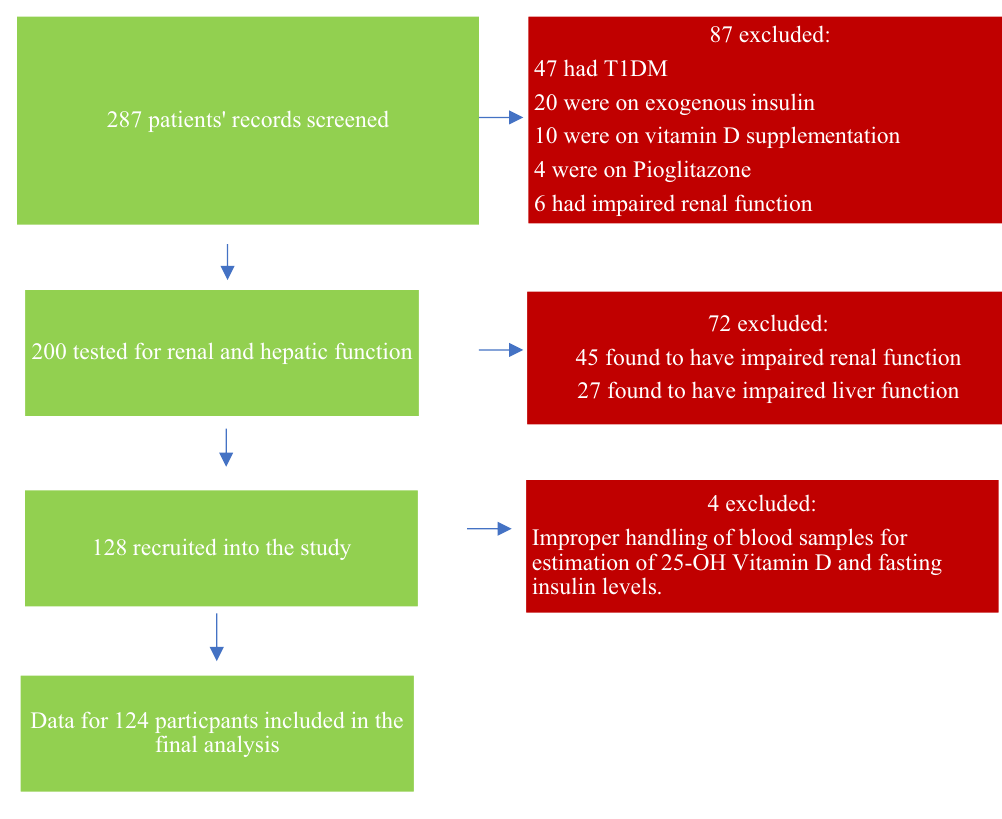
Figure 1. Patient recruitment schema flow chart.